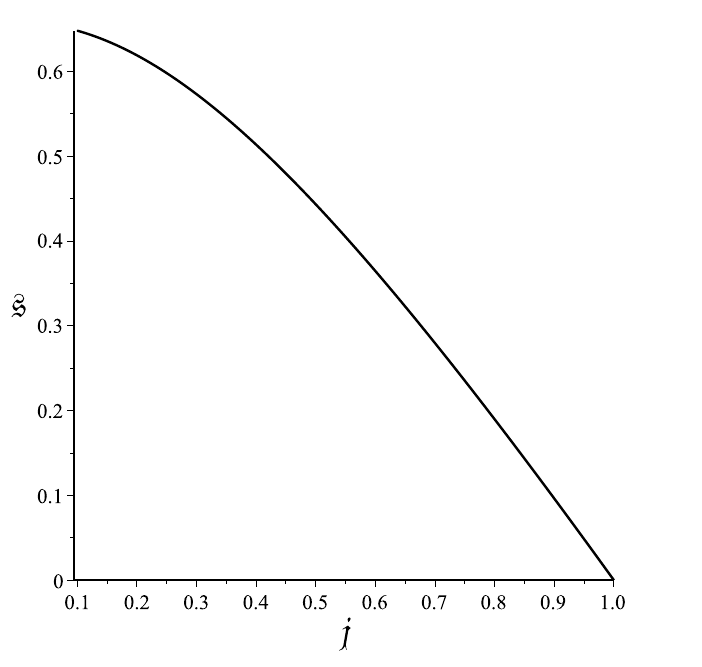
Figure 6 . Specific entropy of a five-dimensional asymptotically AdS 5 Kerr black hole with fixed temperature 2 in units with L = 1 , as a function of the specific angular momentum.